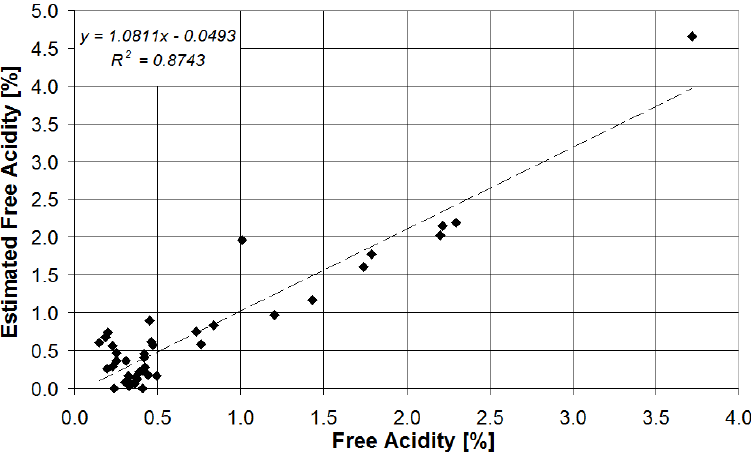
Figure 12. Estimated value of free acidity using the compensation algorithm of Equation (13) and the polynomial function of order 1 plotted vs. the free acidity determined with the reference pro- cedure.